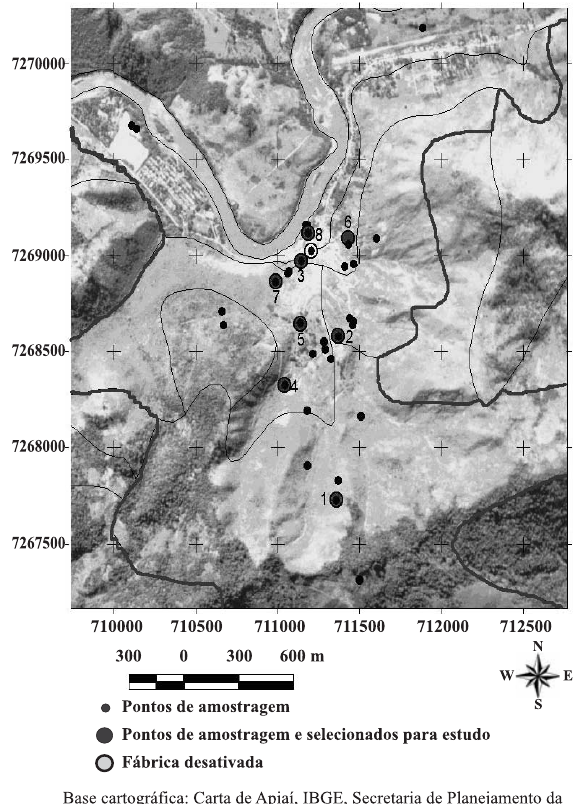
Figura 1. Foto aérea georreferenciada com os compartimentos geomorfológicos (linhas finas), localização da fábrica desativada, pontos de amostragem para reconhecimento da área (círculos pretos pequenos) e locais selecionados para o presente estudo (solos 1 a 8 - círculos pretos